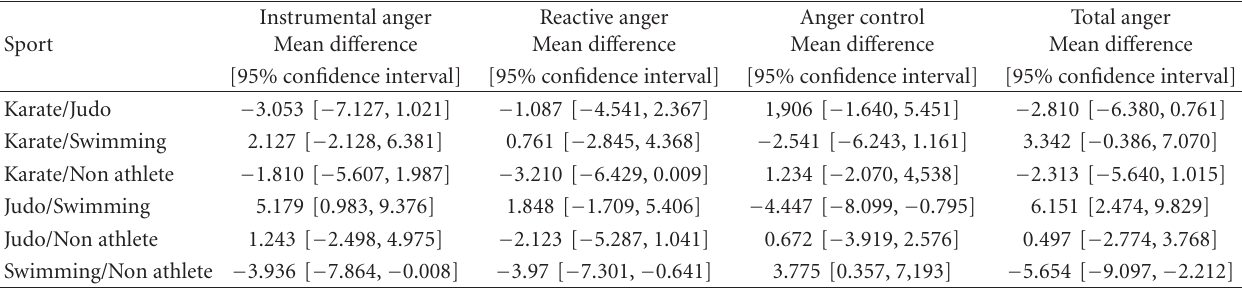
Table 3: E ff ect sizes of anger scale and subscale comparison by type of